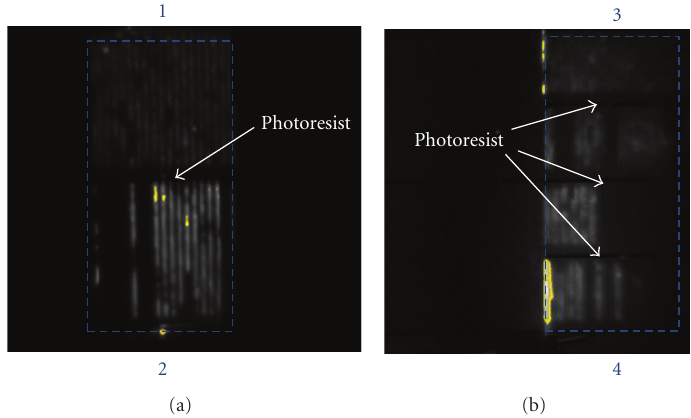
Figure 6: DLIT images for the cell with baked photoresist as the isolation material taken at the forward bias condition: 400 mV, lock-in frequency: 10Hz, scale: − 0.1 mK to 1 mK; (a) image is for the 2-cell minimodule on the left biased between points 1 and 2; (b) image is for the 4-cell minimodule on the right biased between points 3 and 4.